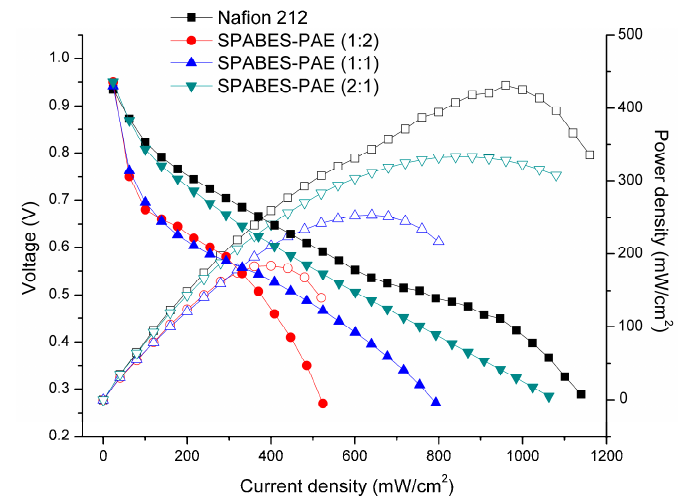
Figure 7. Fuel cell performance of membranes at 60 °C under 100% RH.